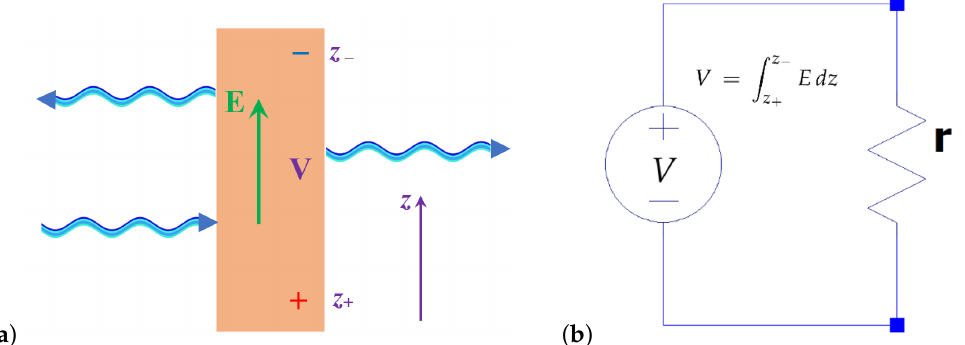
Figure 2. ( a ) Schematics of a wave impinging on a lossy dielectric slab at normal incidence. E is the total electric field in the slab. ( b ) A qualitative equivalent circuit. The voltage V across a given section [ z + , z − ] of the slab is the line integral of E over that segment (see text). Resistance r represents losses in the slab.